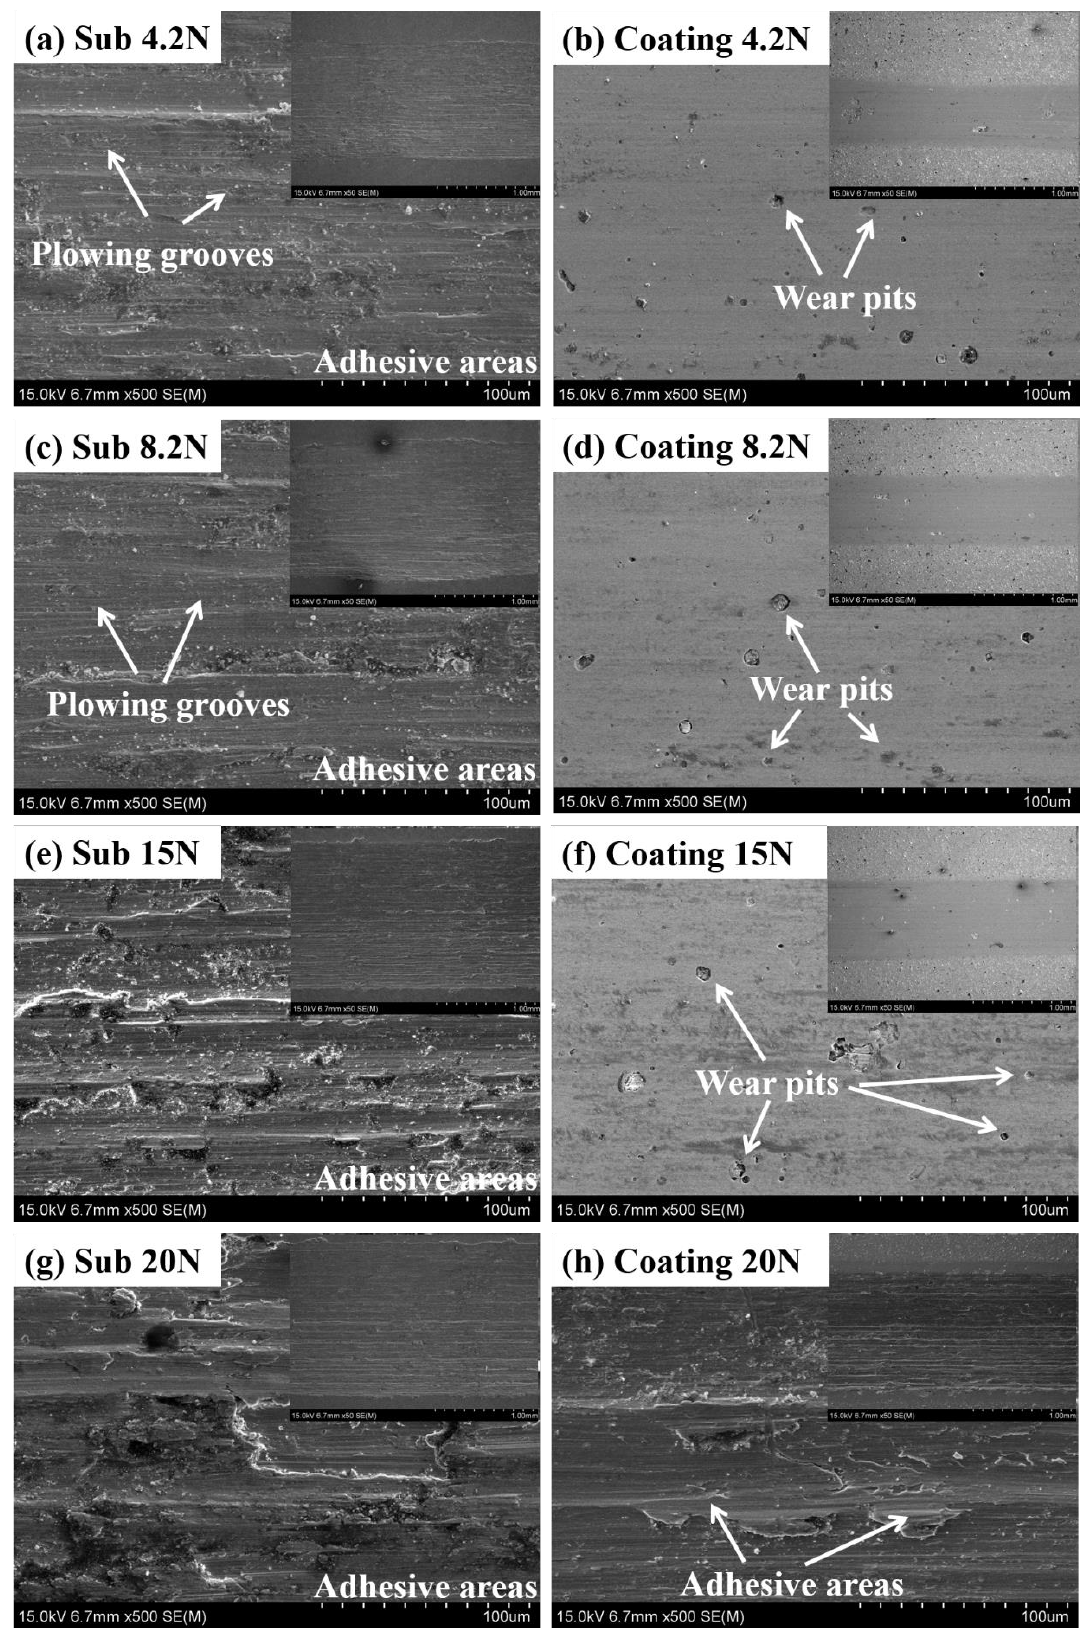
Figure 8. Wear scar morphologies of substrate and composite coating specimens under different axial loads: ( a,b ) 4.2 N; ( c,d ) 8.2 N; ( e,f ) 15 N; and ( g,h ) 20 N.